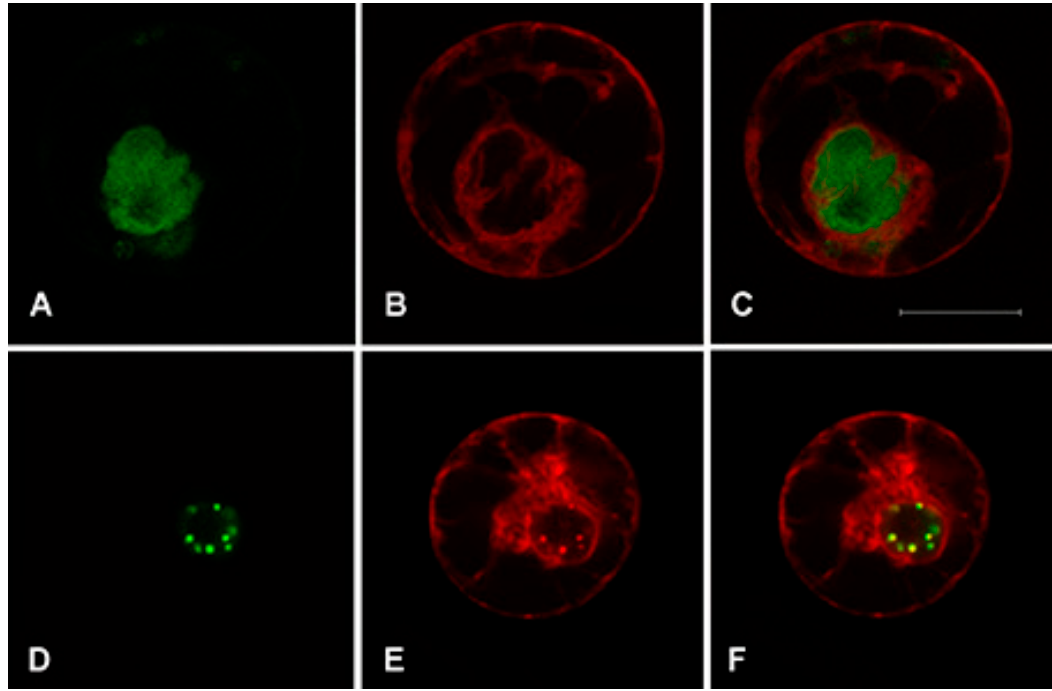
Figure 3. Artemisia annua protoplasts transiently expressing WRKY40:GFP and RFP-KDEL. Panels ( A , D ) show GFP signal in green; panels ( B , E ) show RFP signal in red and panels ( C , F ) show the merge of the two fluorescent signals producing yellow color if overlapping. Scale bar: 20 µ m.